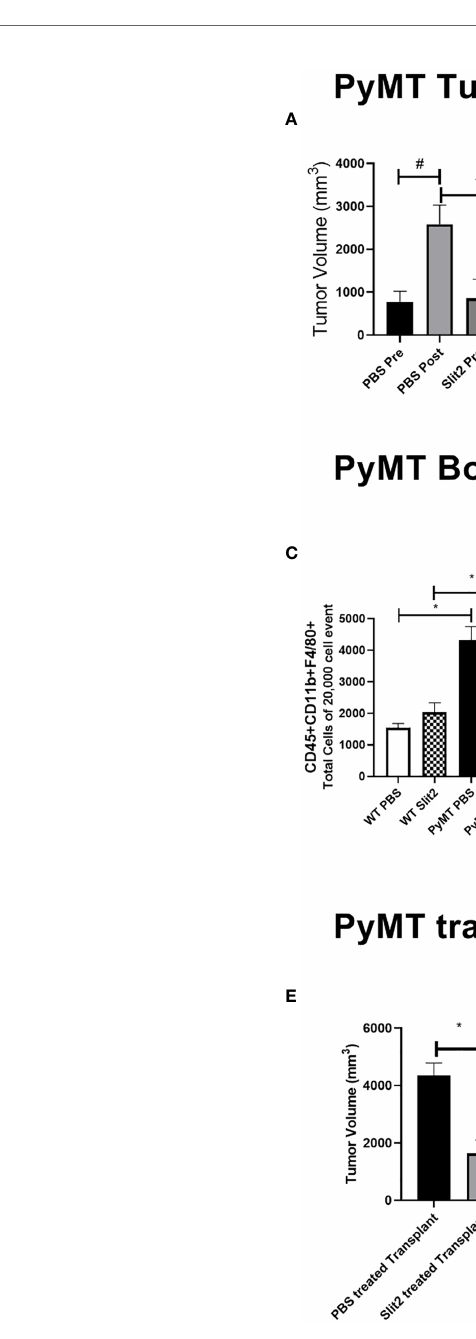
FIGURE 1 | (A) TumorvolumemeasuredbeforeandattheendofPBSorSlit2treatmentinPyMTmice. (B) Tumor-associatedpopulationofCD45+F4/80+CD38+M1macrophages inthearbitrary20,000events collected. (C) BonemarrowpopulationofCD45+CD11b+ F4/80+macrophagesinthearbitrary20,000eventscollected. (D) Bonemarrow populationofCD45+ F4/80+CD38+ M1macrophagesinthearbitrary20,000eventscollected. (E) Tumor volumemeasuredinmyeoloablatedPyMT transplantedwitheither Slit2-pretreatedor PBS-pretreatedallograft. (F) Tumor-associatedpopulationofCD45+ F4/80+CD38+M1macrophagesinmyeoloablatedPyMTandtransplantedmice. The imagesrepresentn= 3 – 5 mice/group. *represents p<0.05signi fi cantdifferencebetweenWTandPyMT